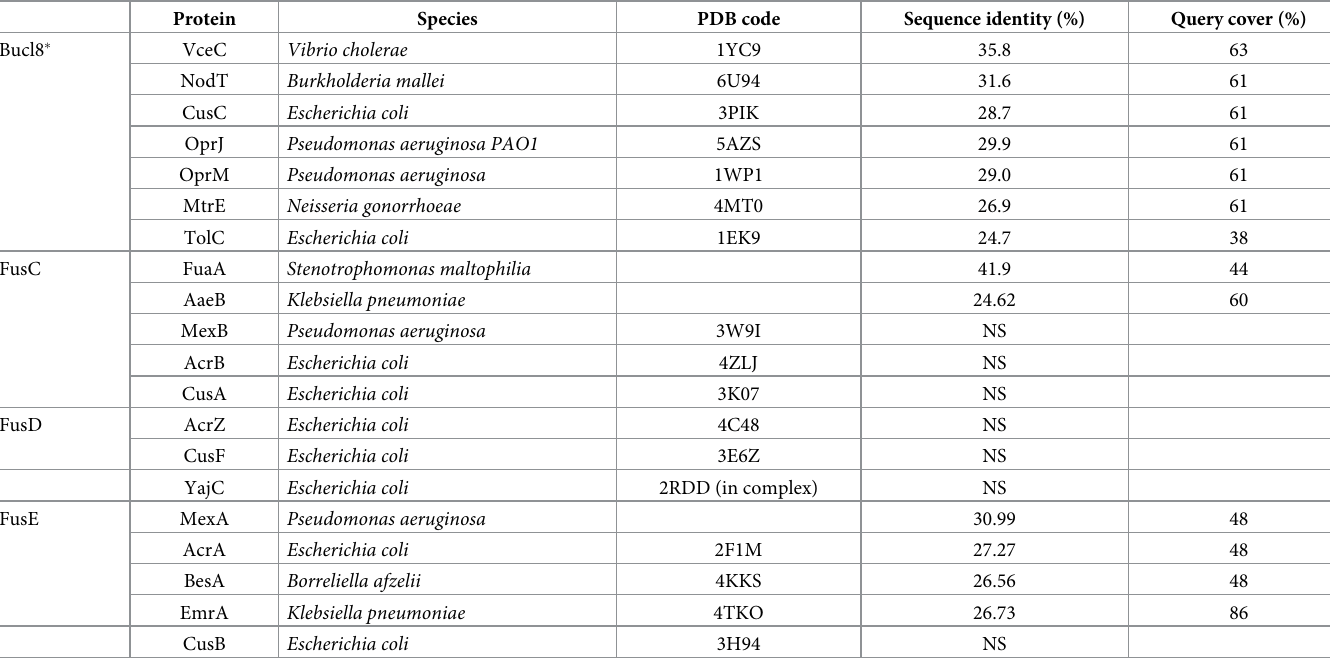
Table 2. Sequence identities between Bucl8-associated efflux pump components and known corresponding